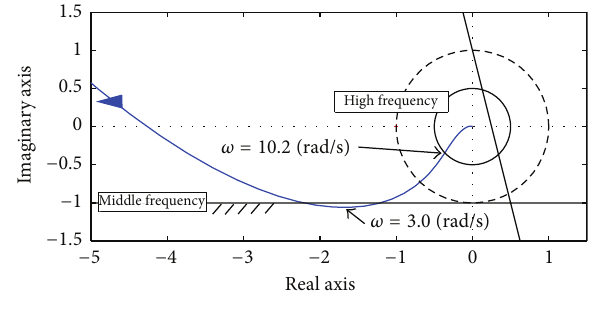
Figure 7: Nyquist plot (magnification).